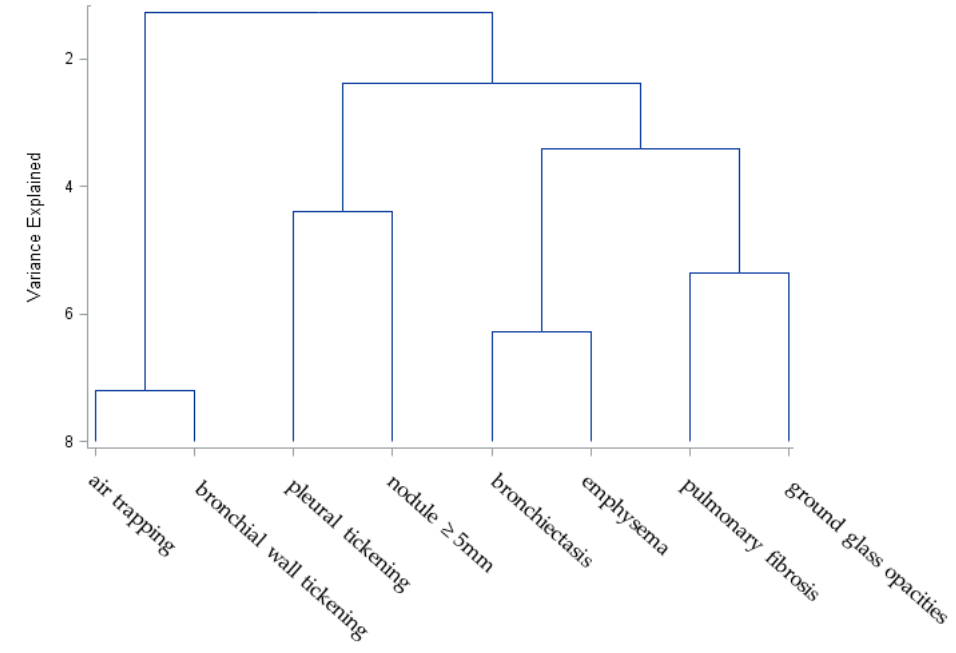
Figure 2. Chest CT abnormalities in WTC-exposed firefighters. The dendrogram demonstrates clustering of abnormalities on chest CTs.